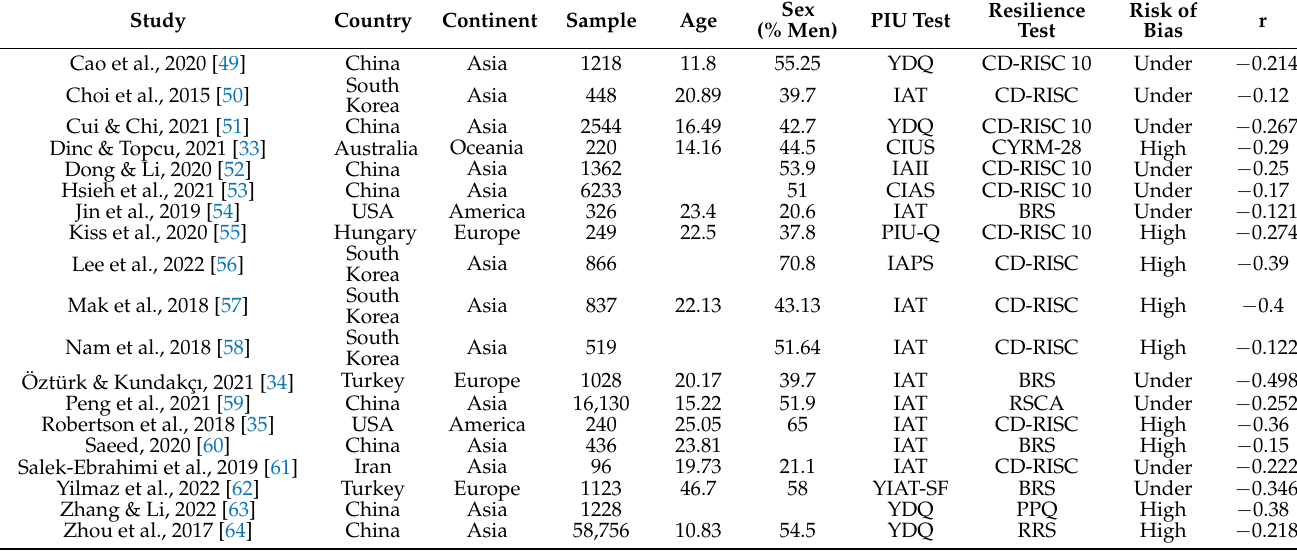
Table 1. Summary of studies included in the